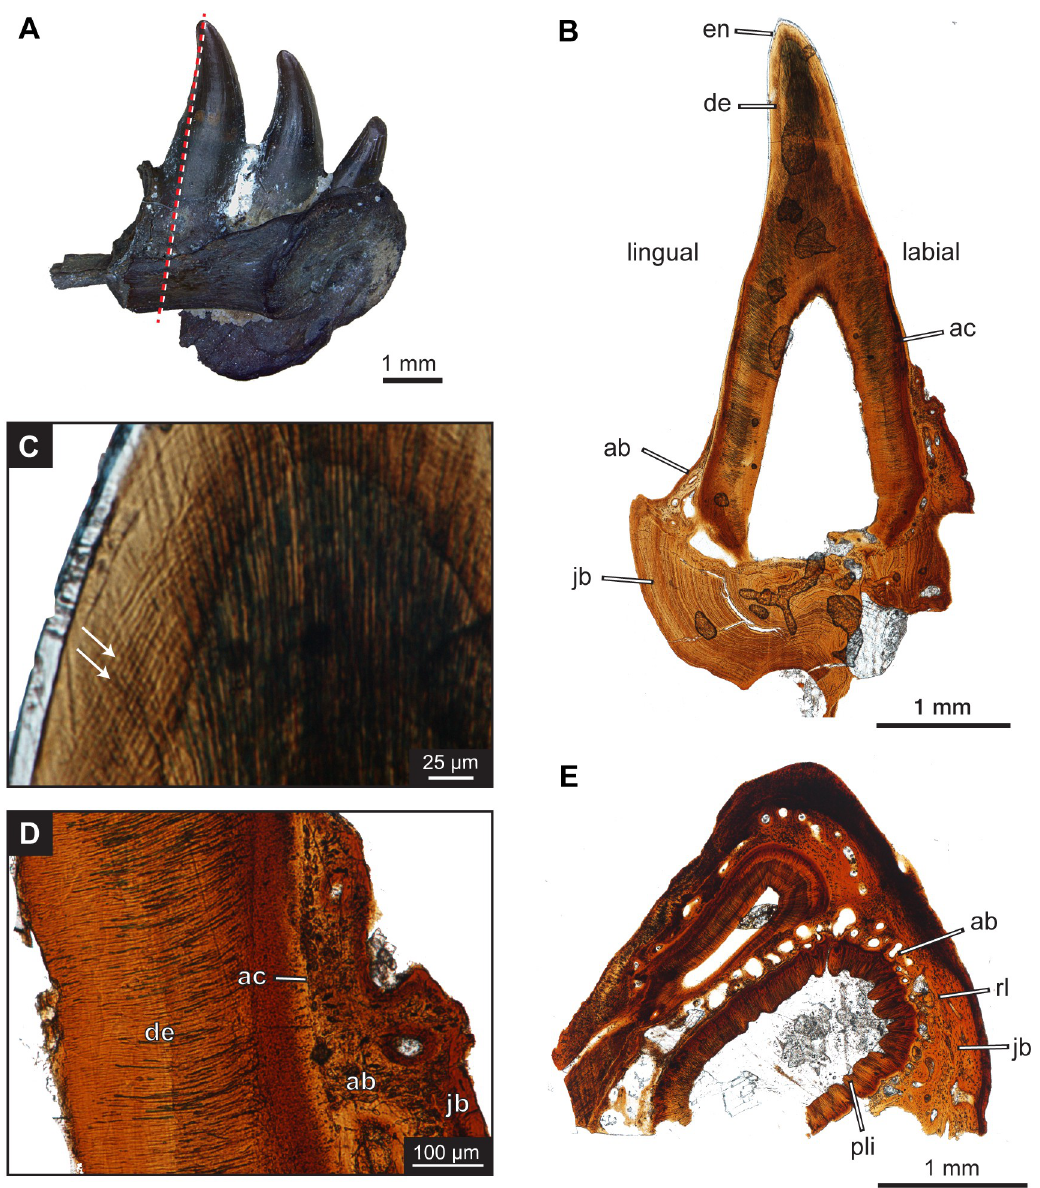
Fig 9. Histology of Maiothisavros dianeae left dentary (ROMVP87370). (A) Lingual view of fragmented left dentary with dashed red line showing the plane of the longitudinal section through the functional tooth. (B) Complete view longitudinal thin section at tooth position 3. (C) Close-up view of functional tooth section showing incremental lines, white arrows. (D) Close-up section showing tooth attachment tissues. (E) Cross-section near the tooth base showing plicidentine. Abbreviation: ab, alveolar bone; ac, acellular cementum; de, dentine; en, enamel; jb, jawbone; pli, plicidentine; rl, reversal